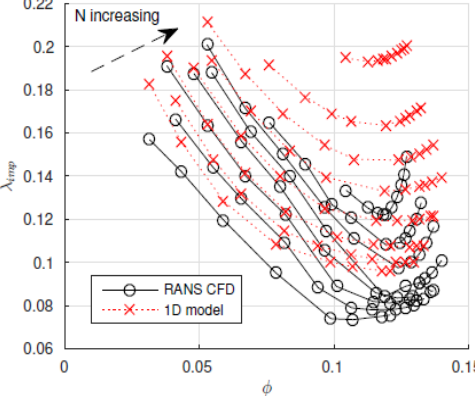
Figure 3. Impeller Losses of RANS CFD and the 1D Model.